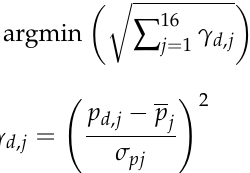
where p and σ pj represent the average and the standard deviation of MSLP in the j -th point, respectively. Computing the previous equations for each day of a specific weather circulation type, the day with lowest δ d can be identified and used as the closest to the climatology of this weather circulation type [32].